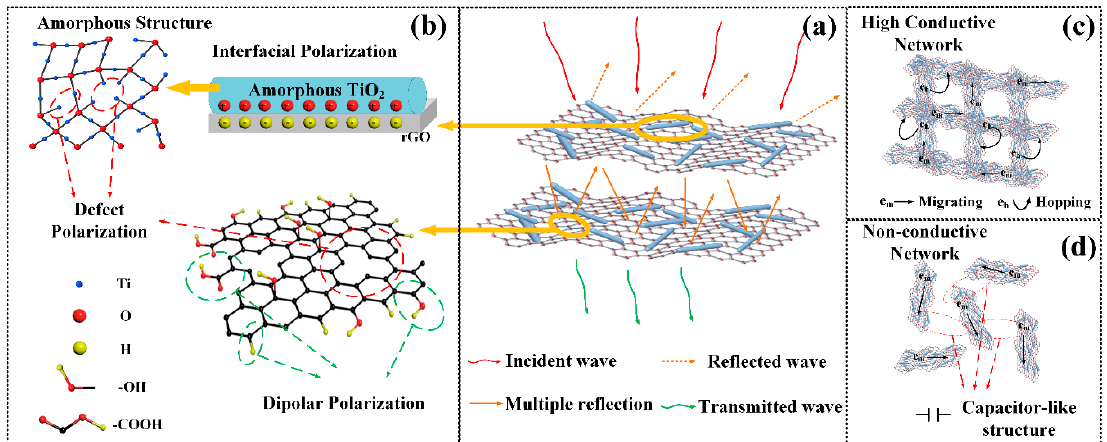
Figure 8. Schematic illustration of electromagnetic wave absorption mechanism of a-T2. ( a ) multiscattering loss, ( b ) polarizations loss, ( c ) conductive loss and ( d ) capacitor-like loss.